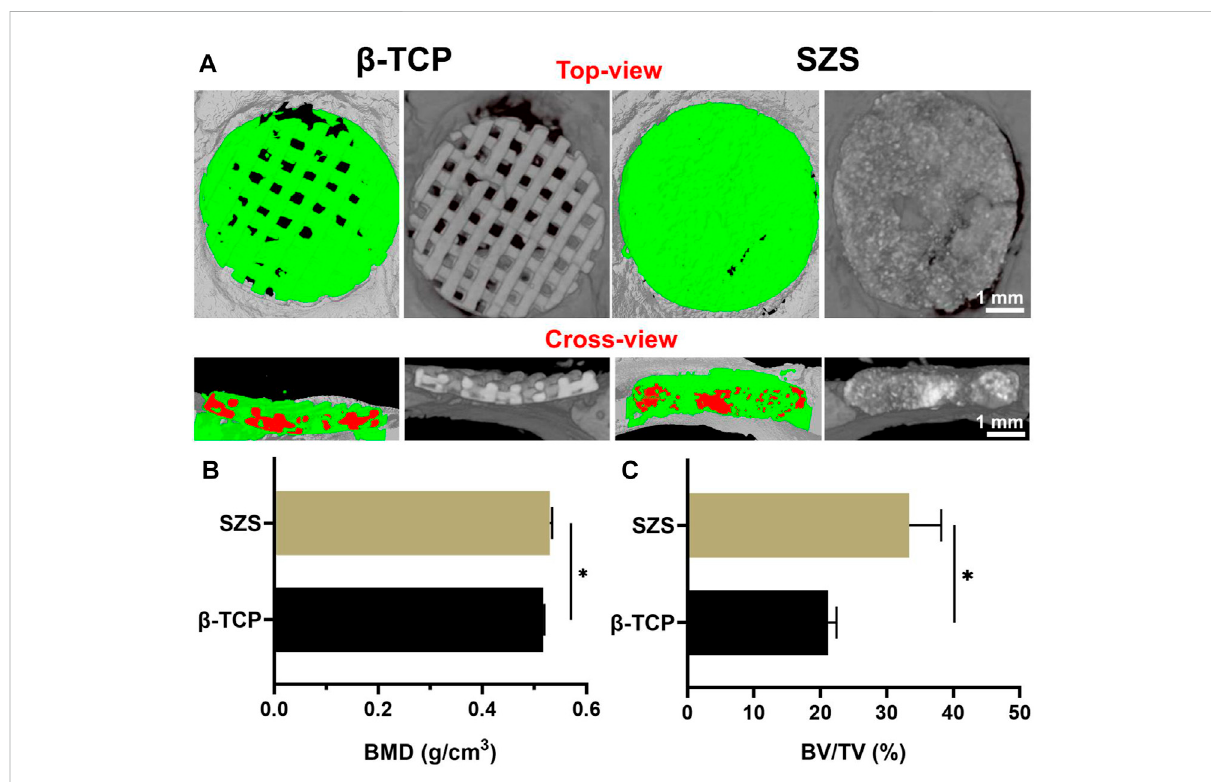
FIGURE 6 Micro-CT analysis of new bone formation in defect areas after implantation of 3D printed SZS and β -TCP scaffolds for 2 months (A) Typical 3D reconstruction of micro-CT images from the top view and cross-view. Green color shows newly formed bone, and red color represents materials. Quantitative analysis of (B) bone mineral density (BMD) ( n = 4) and (C) bone volume/total volume (BV/TV) from micro-CT data. ( n = 4). * p <